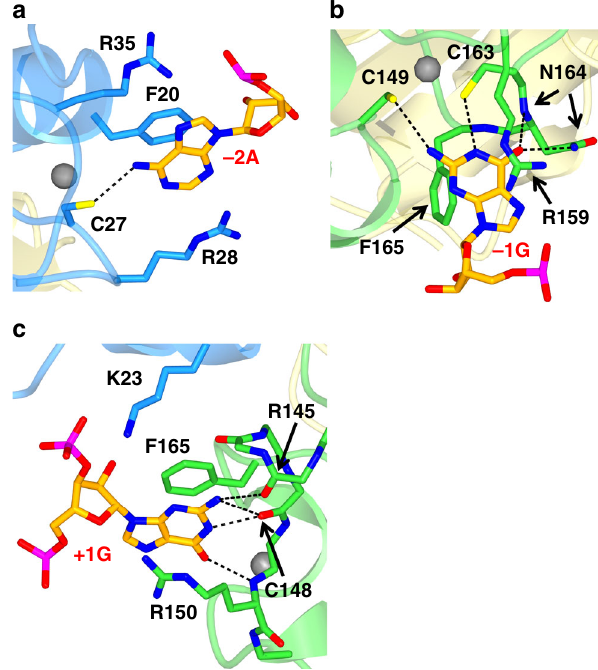
Fig. 2 Representative views of the U2AF1 interactions with each nucleotide at the 3 ′ splice site. a Interaction of U2AF1 with adenine at − 2 position. b Interaction of U2AF1 with guanine at − 1 position and ( c ) with guanine at + 1 position structures. In U2AF1, ZF1, ZF2, and RNA are colored as in Fig.